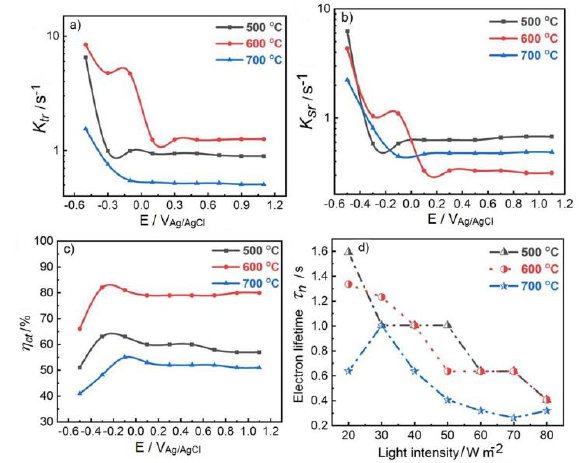
Figure 8. Kinetic parameters retrieved from IMPS and IMVS measurements. ( a ) Hole transfer rate ( K tr ), ( b ) surface recombination rate of holes ( K sr ), and ( c ) hole transfer efficiency ( η ct ) at different applied potentials. ( d ) Bulk recombination rate of electron obtained from IMVS measurements performed under open circuit conditions.